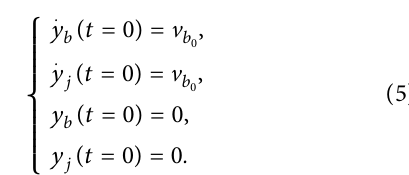
Figure 1: Single degree of freedom